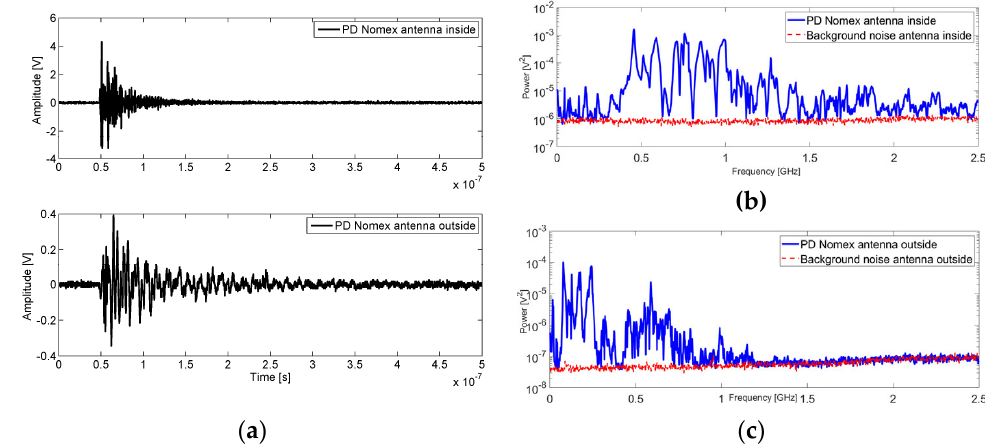
Figure 5. ( a ) Internal PD pulse for Nomex measured by both antennas; ( b ) frequency spectrum of the PD pulse compared to background noise inside the tank and ( c ) outside the